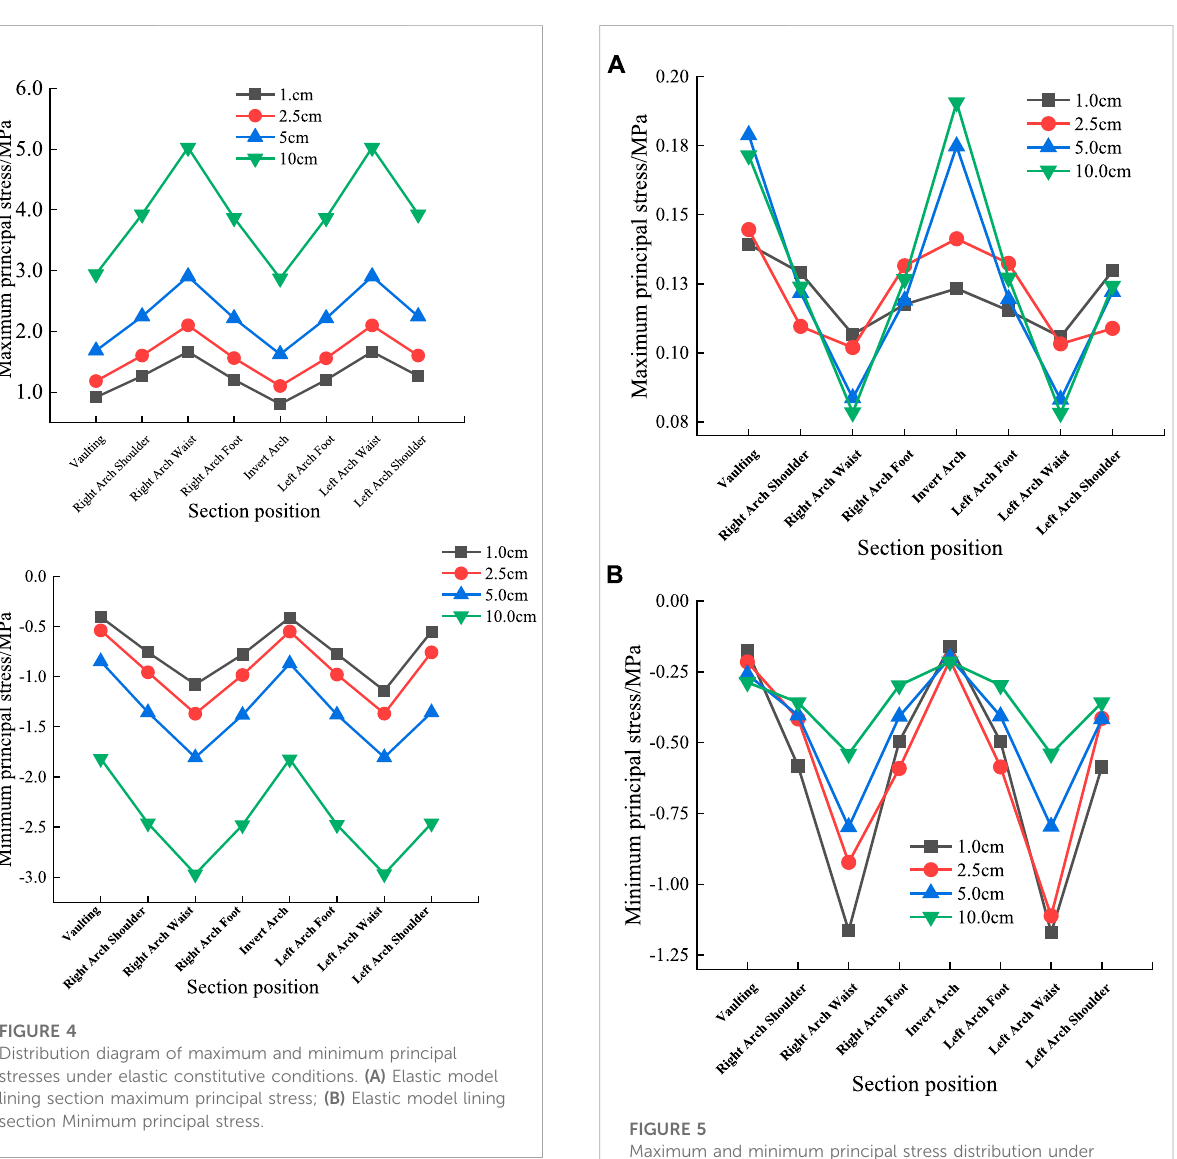
Maximum and minimum principal stress distribution under plasticity principal structure. (A) Elastic-plastic tunnel section maximum principal stress; (B) Elastic-plastic tunnel section minimum principal